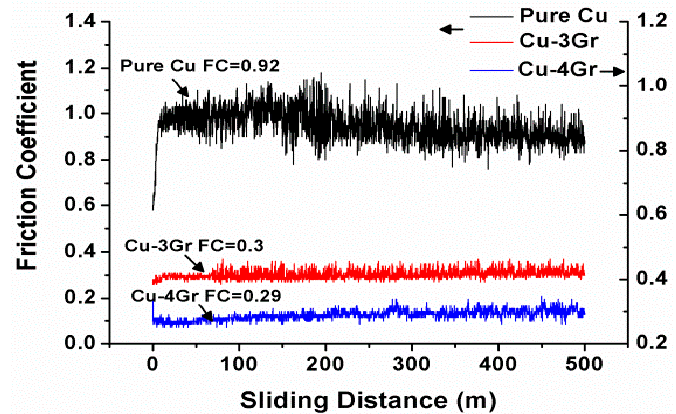
Figure 4. Friction coefficient variations as a function of graphite content.